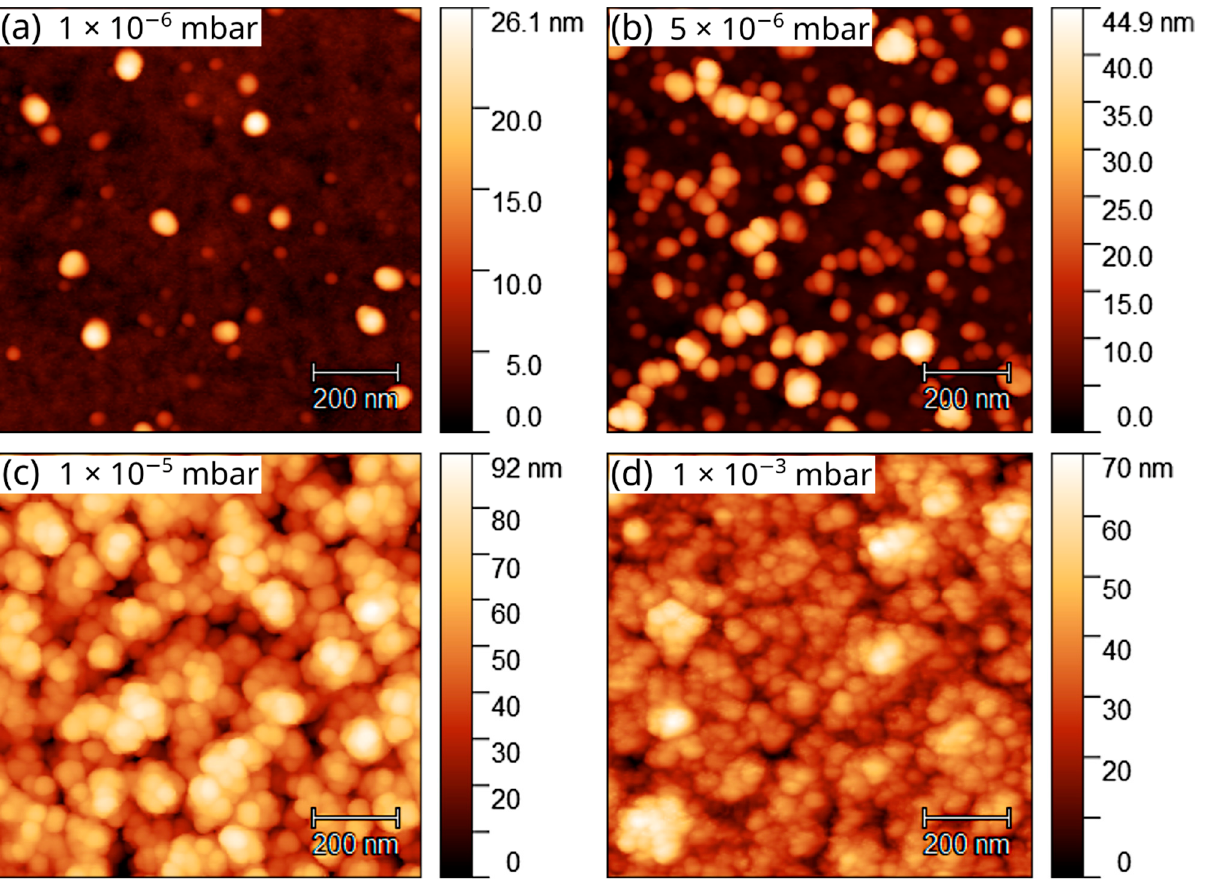
Figure 2. AFM images of hBN samples grown on Ge(001) at ( a ) 1 × 10 − 6 mbar, ( b ) 5 × 10 − 6 mbar, ( c ) 1 × 10 − 5 mbar, and ( d ) 1 × 10 − 3 mbar.